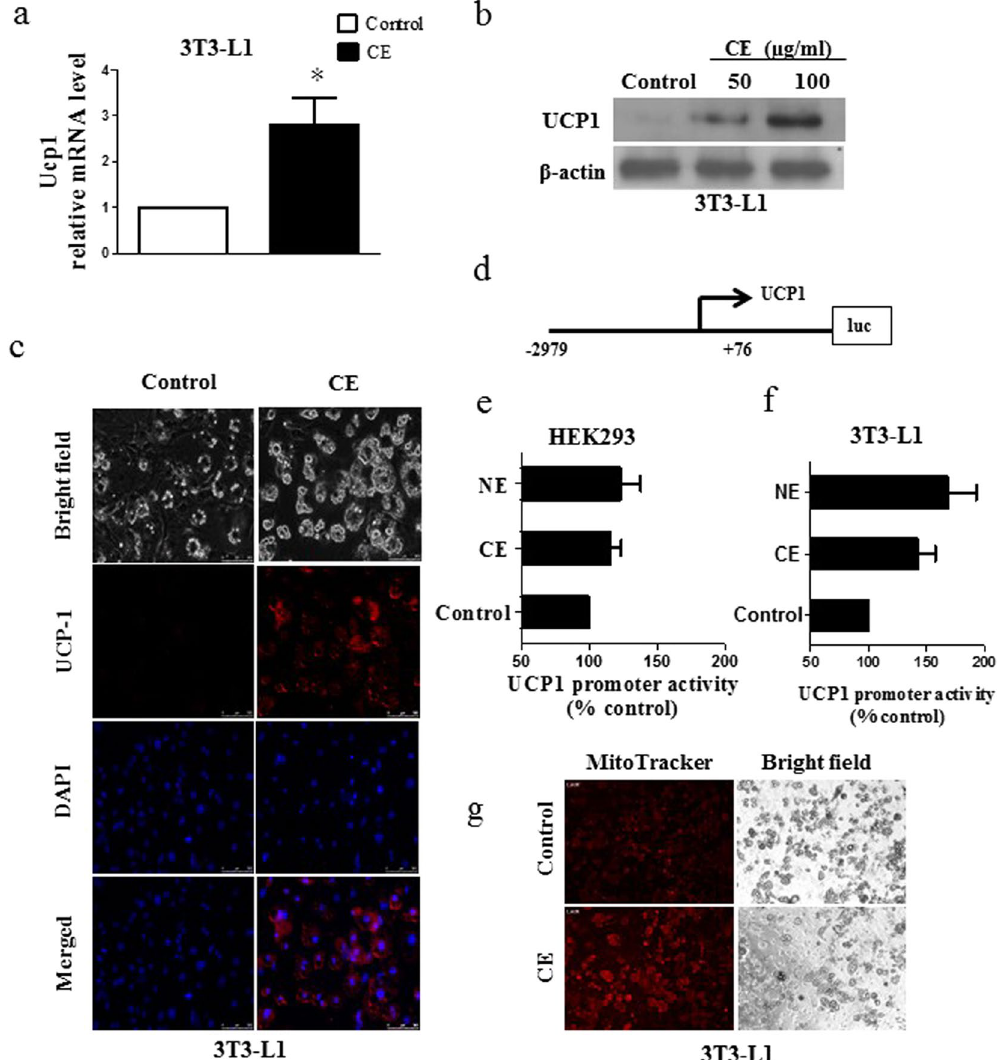
Figure 3. ( a ) Ucp1 mRNA expression, ( b ) UCP1 protein expression and ( c ) immunofluorescence staining of UCP1 in vehicle control and CE-treated 3T3-L1 cells. ( d ) Ucp1 promoter construct ( − 2979 to base + 76) ligated into pGL3-basic luciferase reporter vector. Ucp1 promoter activity in ( e ) HEK293 cells and ( f ) 3T3-L1 cells. ( g ) MitoTracker Green (Molecular Probe) staining of the mitochondria in control and CE-treated 3T3-L1 cells. CE, cinnamon extract (80 µ g/ml); NE, norepinephrine (10 µ M). Ucp1, uncoupling protein 1; DAPI, (4 ′ ,6-diamidino- 2-phenylindole staining). * p < 0.05, n = 3 individual experiments. Original magnification